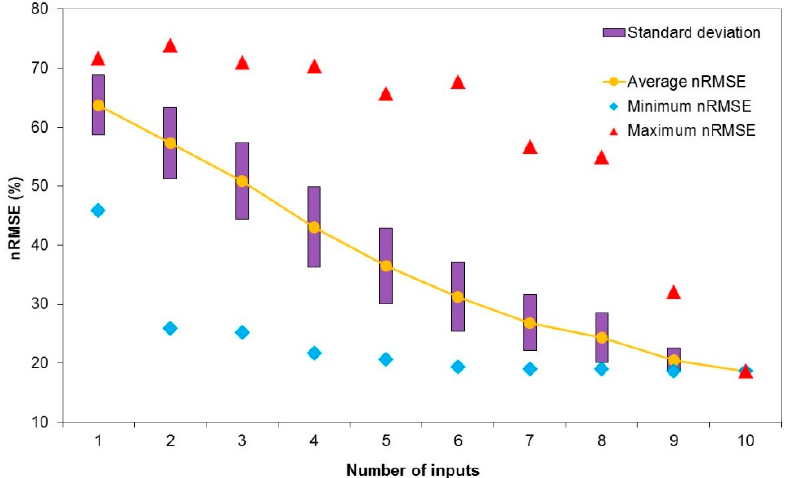
Figure 3. Average, minimum, and maximum values of the nRMSE and its standard deviation versus the number of inputs (Bouzareah site).